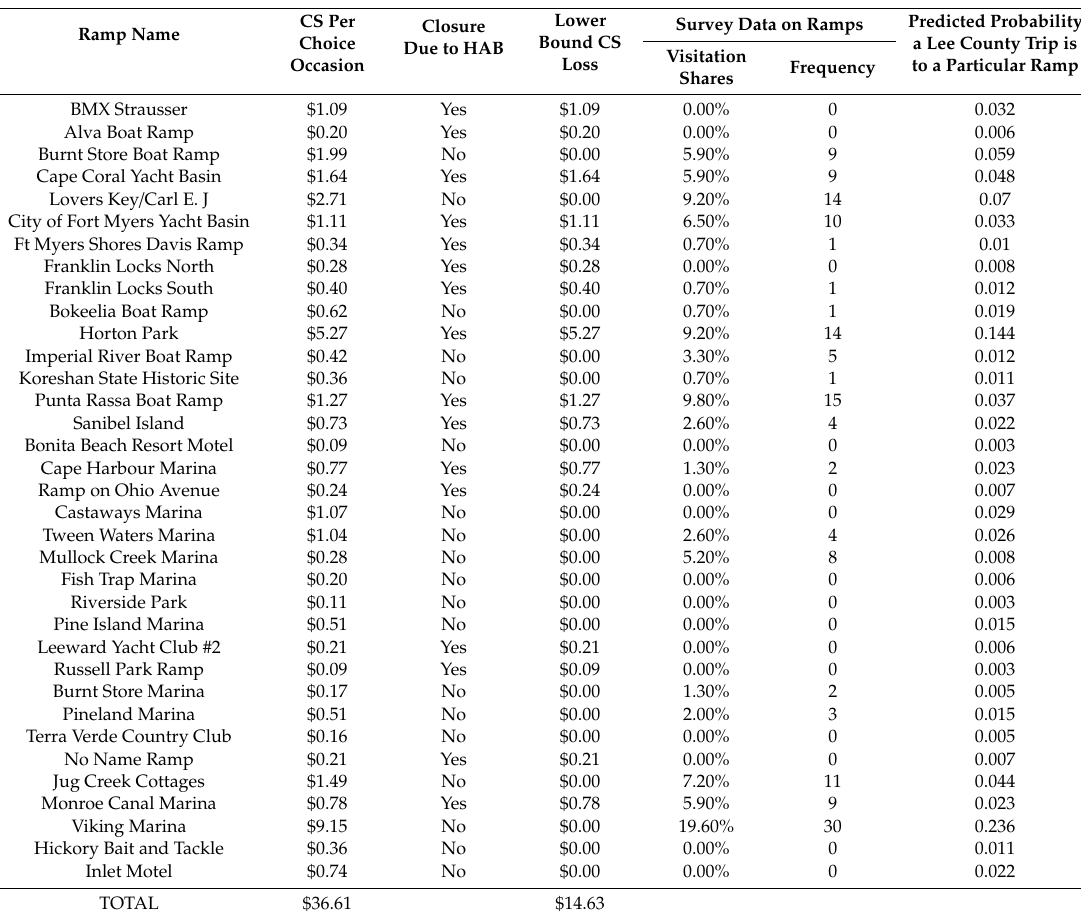
Table 3. Estimated site values and observed and predicted trips to the ramp groups. Sites with closures due to HABs are indicated. Consumer surplus estimates are reported in 2009